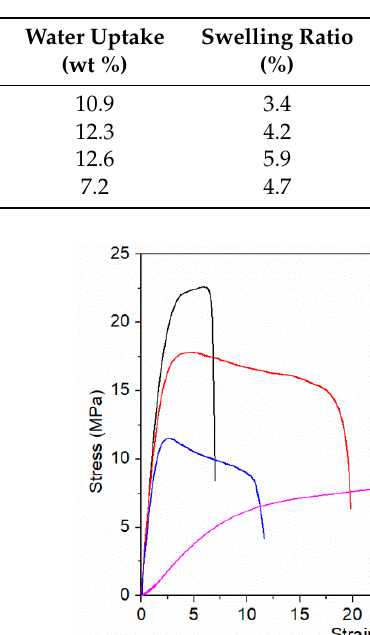
Table 3. Water affinity and mechanical property of SPAEKs and Nafion N212 under ambient RH.